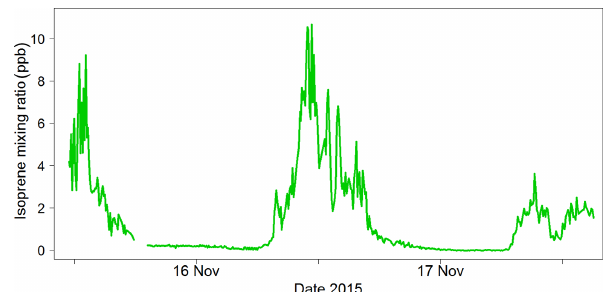
Figure 14. Time series for isoprene at a secondary forest site in Sabah (Malaysian Borneo) in